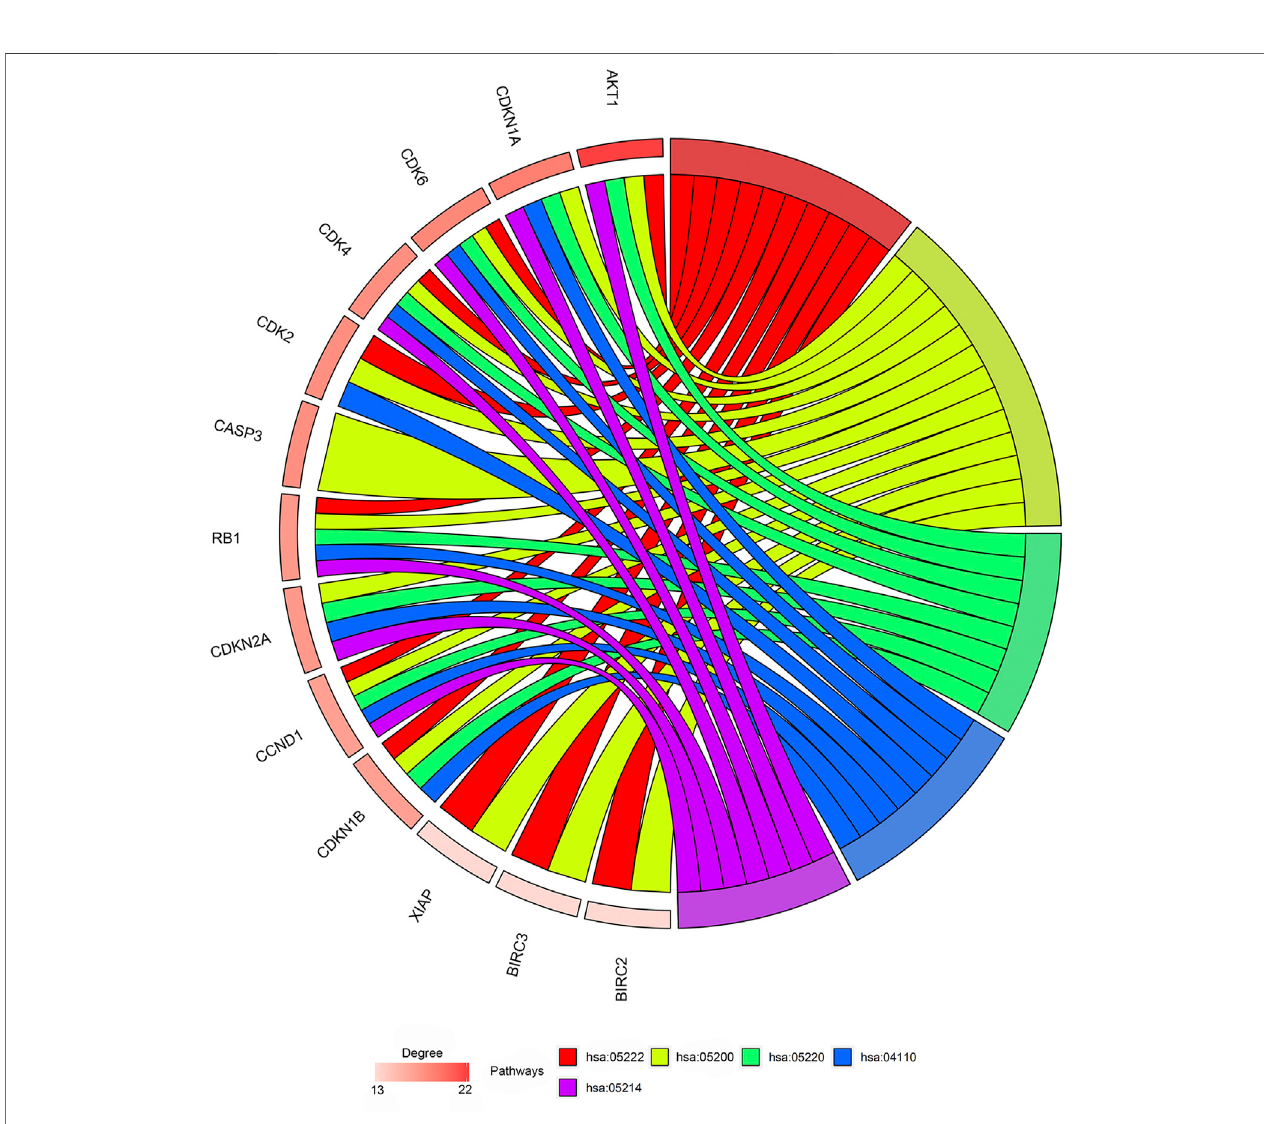
FIGURE 3 | Outcomes of gene enrichment analysis. CCND1, CDK6, RB1, CDK4 were involved in every pathway of the top fi ve. The top three genes with highest degrees are AKT1, CDKN1A, and CDK6. hsa05222: Small cell lung cancer pathway. hsa05200: Pathways in cancer. hsa05220: Chronic myeloid leukemia pathway. hsa04110: Cell cycle pathway. Hsa05214: Glioma pathway.